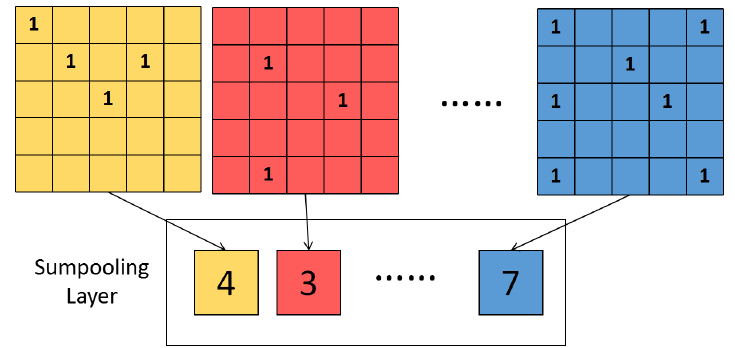
Figure 8. An example of a sumpooling